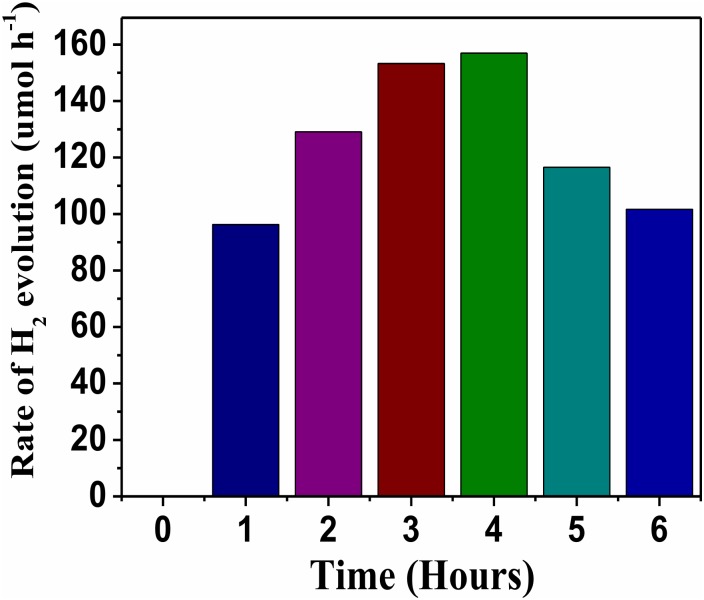
H2 evolution rate by NaNbO3 for 6 h irradiation.